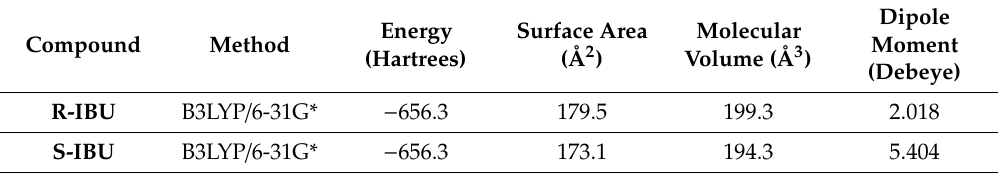
Table 2. Density functional theory (DFT) calculated energy and geometries of R- and S-IBU.